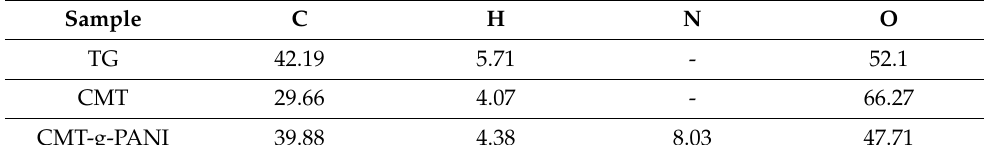
Table 1. Elemental analysis of TG, CMT, and CMT-g-PANI.